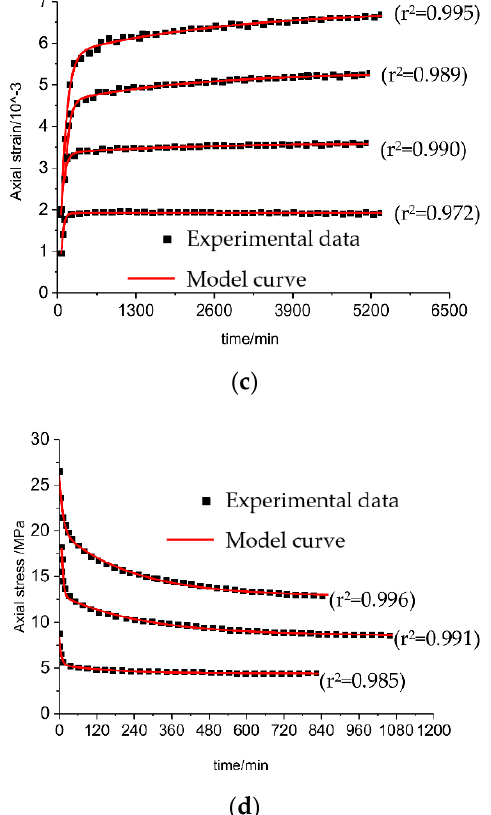
Figure 6. The core damage model curve compared to the creep and stress relaxation behavior of the other rocks. ( a ) Axial strain of a marble at the stress level of 69 MPa under uniaxial compression [27]. ( b ) Axial stress of Cobourg limestone (Cbrg_16R) in the stress relaxation tests [6]. ( c ) Axial strain of a silty mudstone at the stresses of 3, 9, 15, and 17.7 MPa in triaxial compression [16]. ( d ) Axial stress of the silty mudstone at strains of 0.2%, 0.6%, and 1.27% in the triaxial compressive stress relaxation tests [17].